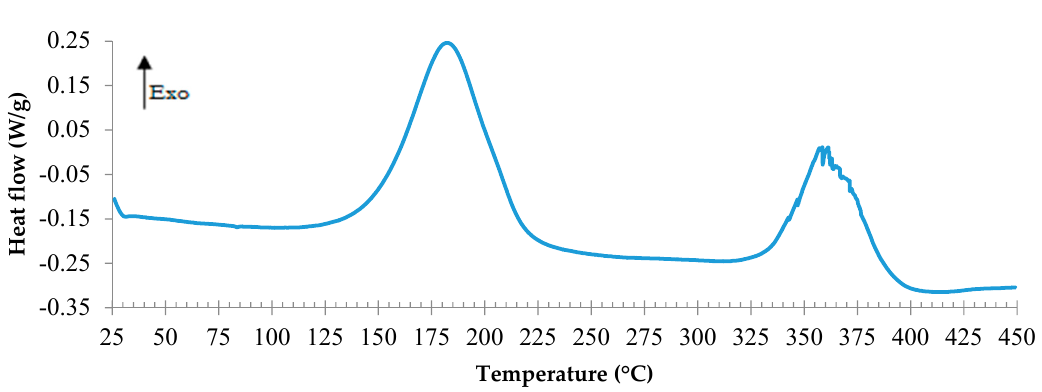
Figure 3. DSC scan of TETM/DDS formulation performed under nitrogen at a heating rate of 3 °C/min.